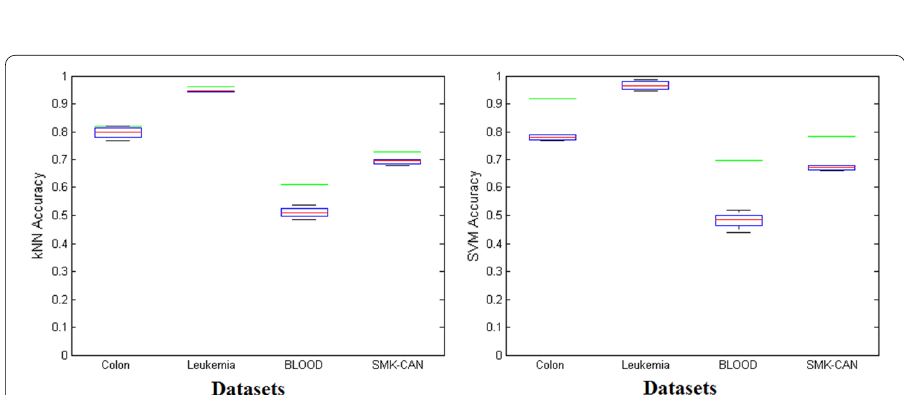
Fig. 12 Accuracy evaluation of ℓ 1 SVM using KNN and SVM. Green line represents Bagging while Black Lines, Red line and Blue box represent maximum, minimum, median and quartile of baseline performance